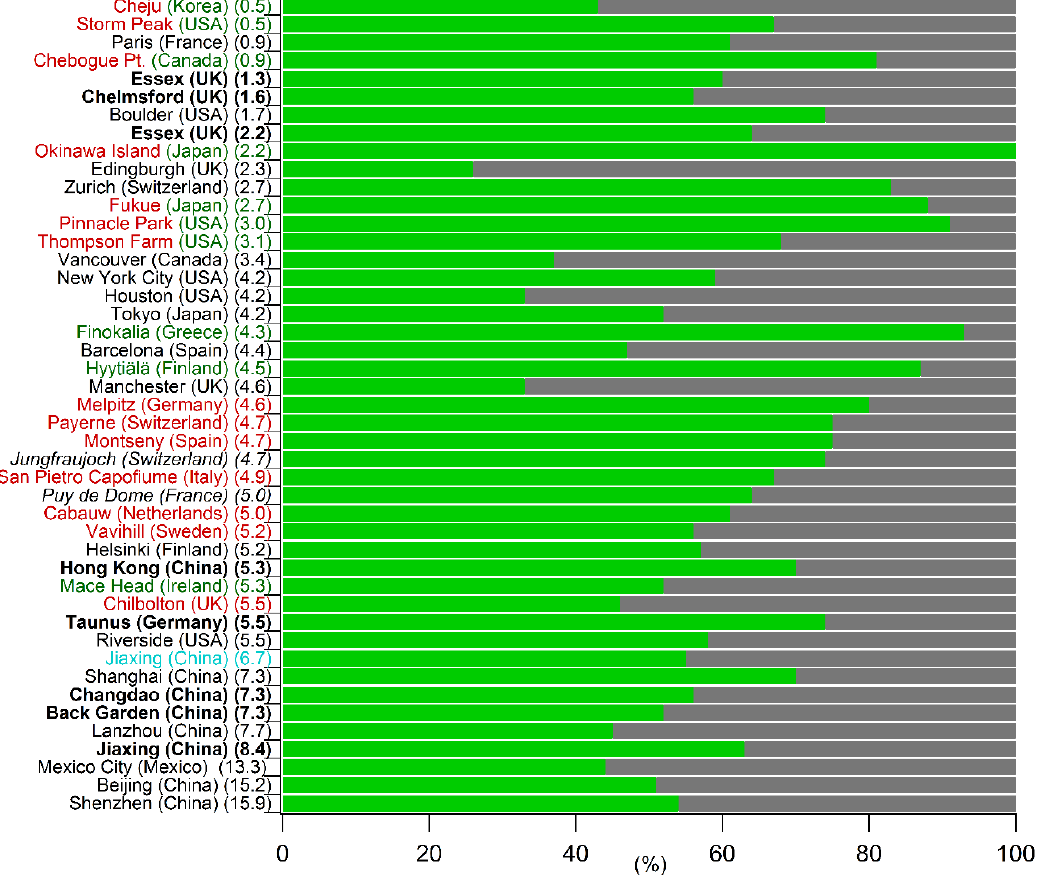
Figure 7. Spring–summer SOC (green) and POC (grey) contributions to PM 1 OC using PMF-AMS (AMS or ACSM) for all the monitored sites referenced in Table SD2. Results are presented in increasing order of OC concentration levels (µgC m −3 ). In black, urban sites; in blue, suburban sites; in red, rural sites; in green, remote sites; in italic, high altitude sites and in bold, urban downwind sites.